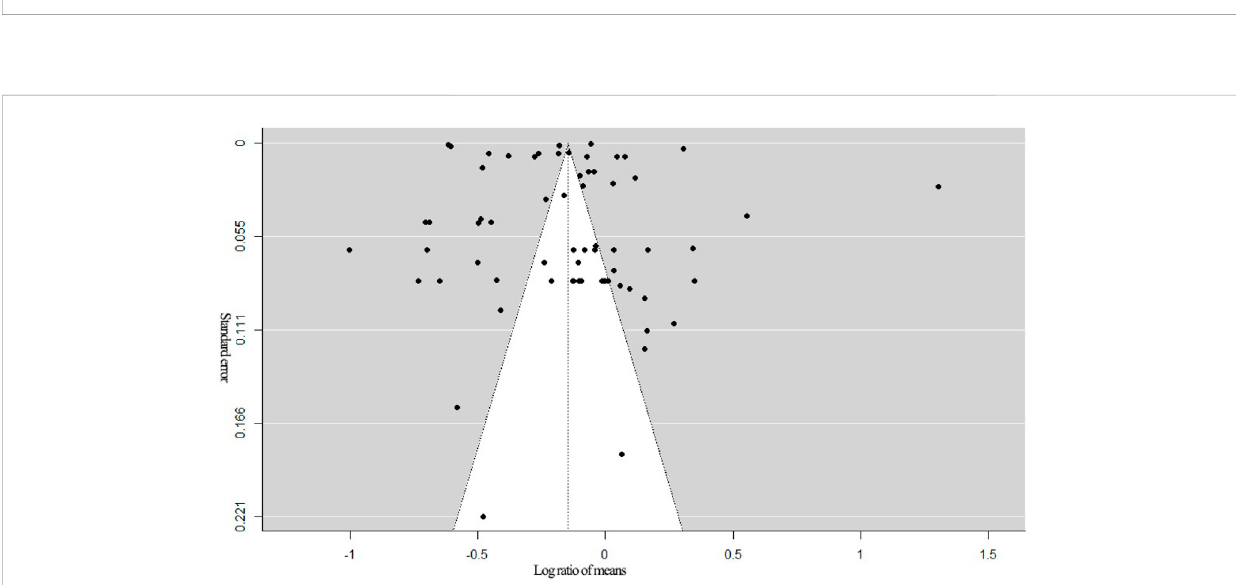
FIGURE 2 Funnel plot of effect sizes of grazing on grassland SOC contents. Note: Egger ’ s regression test for funnel plot asymmetry ( z = − 0.012, p =